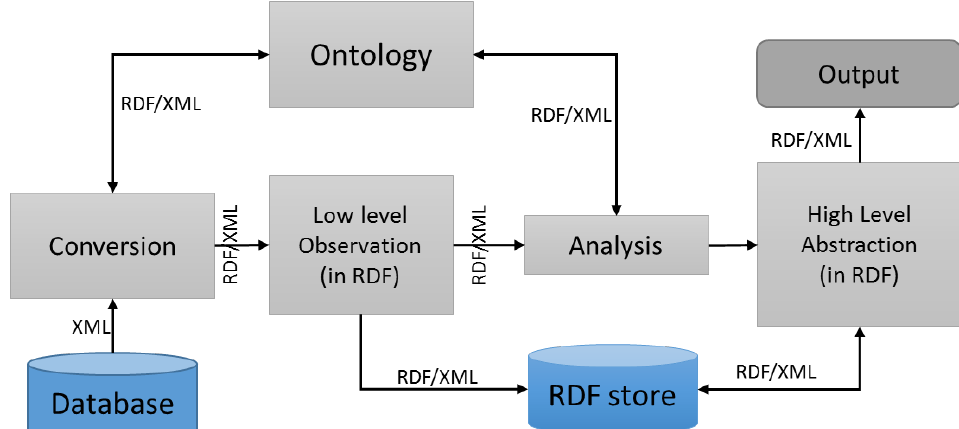
Figure 15. Sensors raw data needs to be abstracted in a machine usable form such as Resource Description Framework